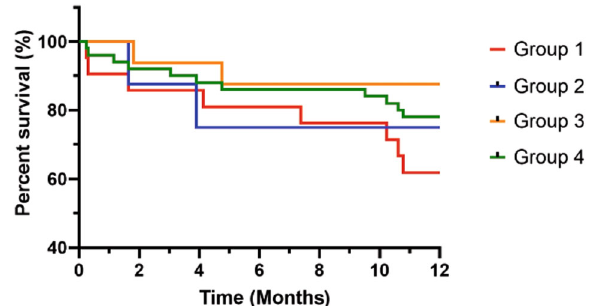
Fig. 2 Kaplan – Meier survival curves for 1-year mortality accord- ing to different recommended prediction indices for palliative care. The 1-year survival rates were 62, 75, 88, and 78% for groups 1 – 4,